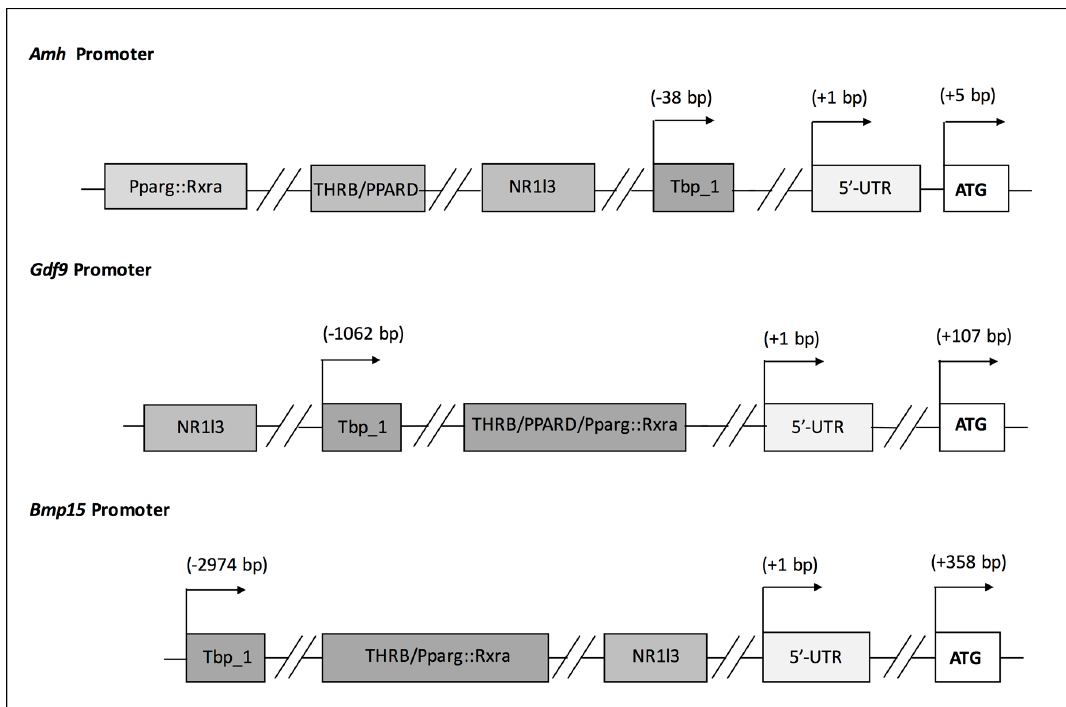
Figure 2. Analysis of mouse Amh , Gdf9 and Bmp15 promoters. List of transcription factor binding sites that were identified by the Jaspar tool analysing the 3000 bp upstream sequence of the genes. The ENSEMBLE Transcript ID were: ( Amh ) ENSMUST00000036016.5; ( Gdf9 ) ENSMUST00000018382.6; ( Bmp15 ) ENSMUST00000024049.7.